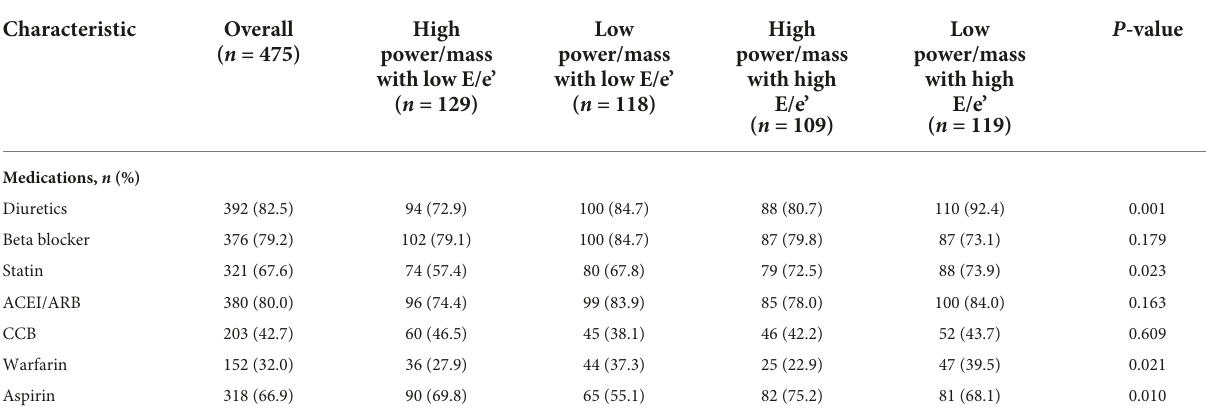
whereas the HRs of low resting power/mass with mortality outcomes did not reach statistical significance. In contrast, values of the E/e’ ratio were significantly higher in patients suffering from adverse outcomes than in those free from the outcomes ( Supplementary Figure 2 ). In multivariate regression analysis, a high E/e’ ratio ( > 15) was significantly associated with a greater risk of poor outcomes in patients with HFpEF ( Supplementary Table 3 ). Outcomes differed by power/mass and E/e’ groups, with a trend toward increased risk of poor outcomes from the HP- NF group to the LP-HF group. The cumulative incidences of primary outcomes according to the pre-specified four groups are shown in Table 2 and Figure 1 . In comparison with an incidence